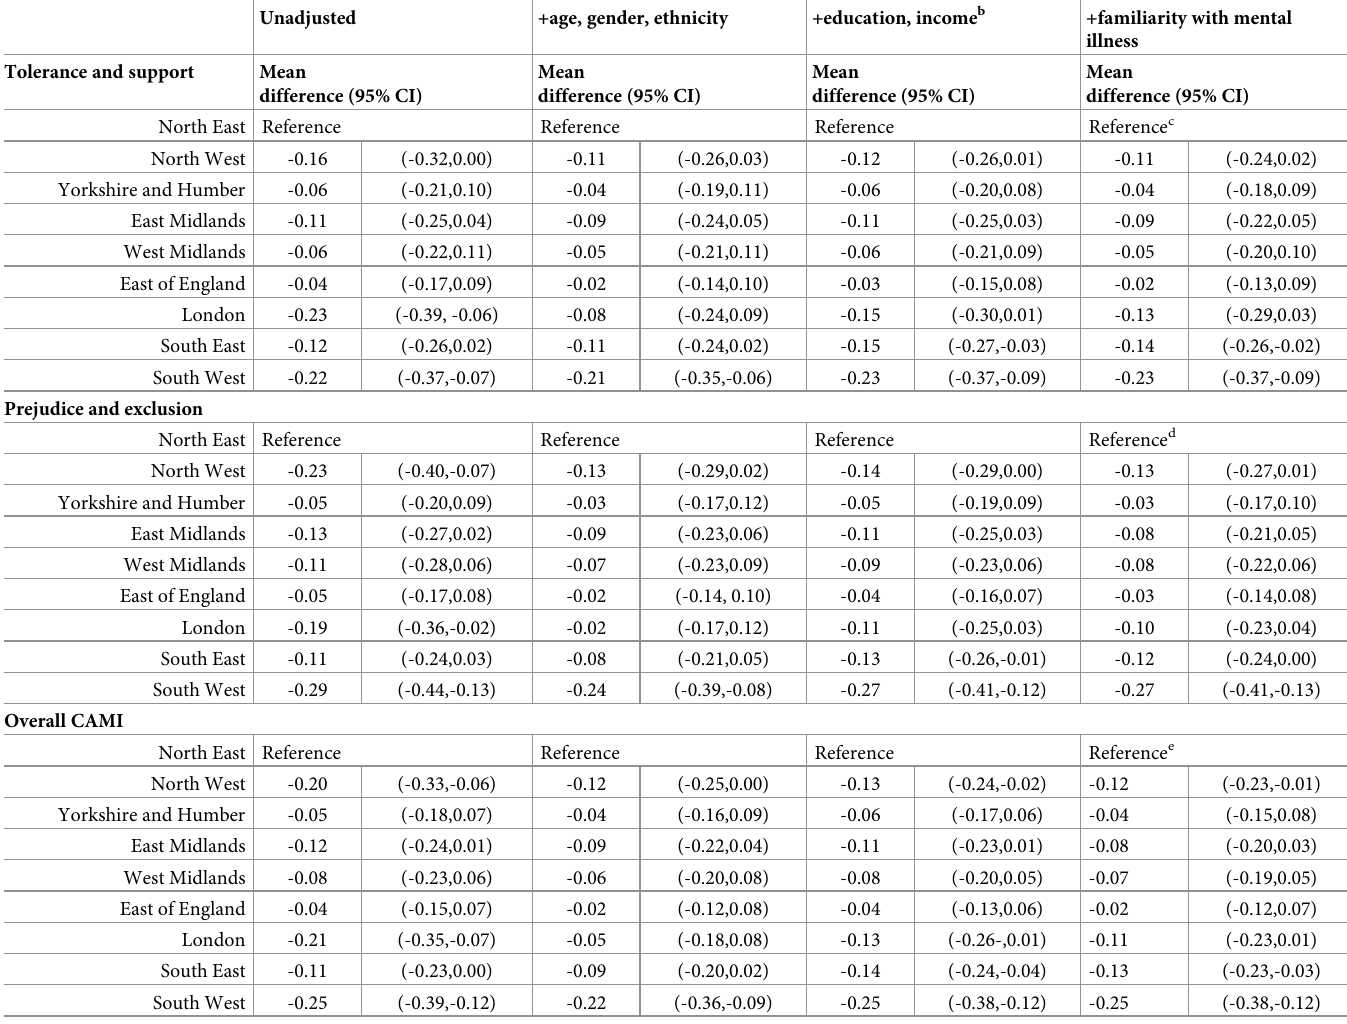
Table 3. Partial- and fully adjusted estimates for the association between region and mental health-related attitudes, weighted for clustered sampling and non- response. Models are based on 4277 participants with complete data on modelled variables.